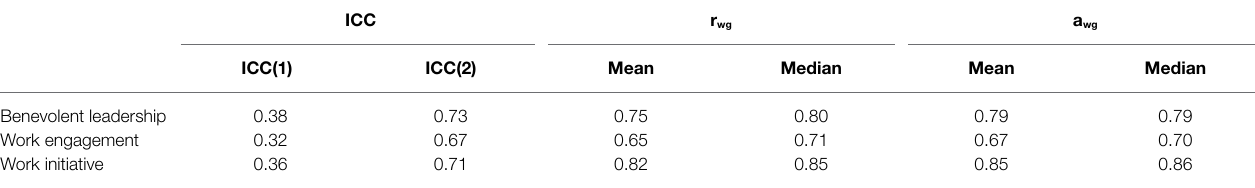
TABLE 1 | Aggregation and within-group agreement indices.